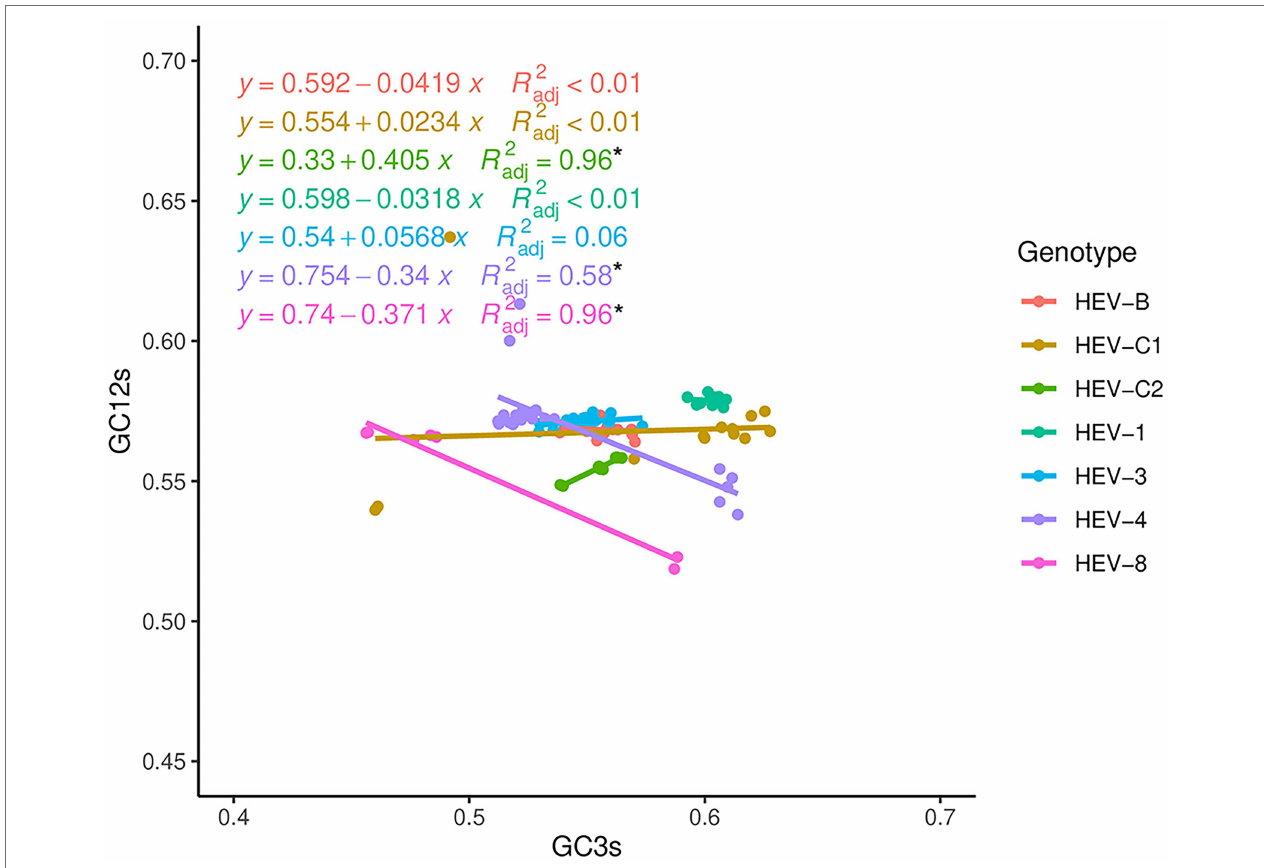
FIGURE 5 | Neutrality analysis based on the HEV complete coding sequences. The correlation between GC content at first and second positions of codon (GC12s) and at third position of codon (GC3s) was calculated. The solid lines by colors represented the linear regression of GC12 against GC3s for the seven HEV genotypes. * Represented correlation significant at p <